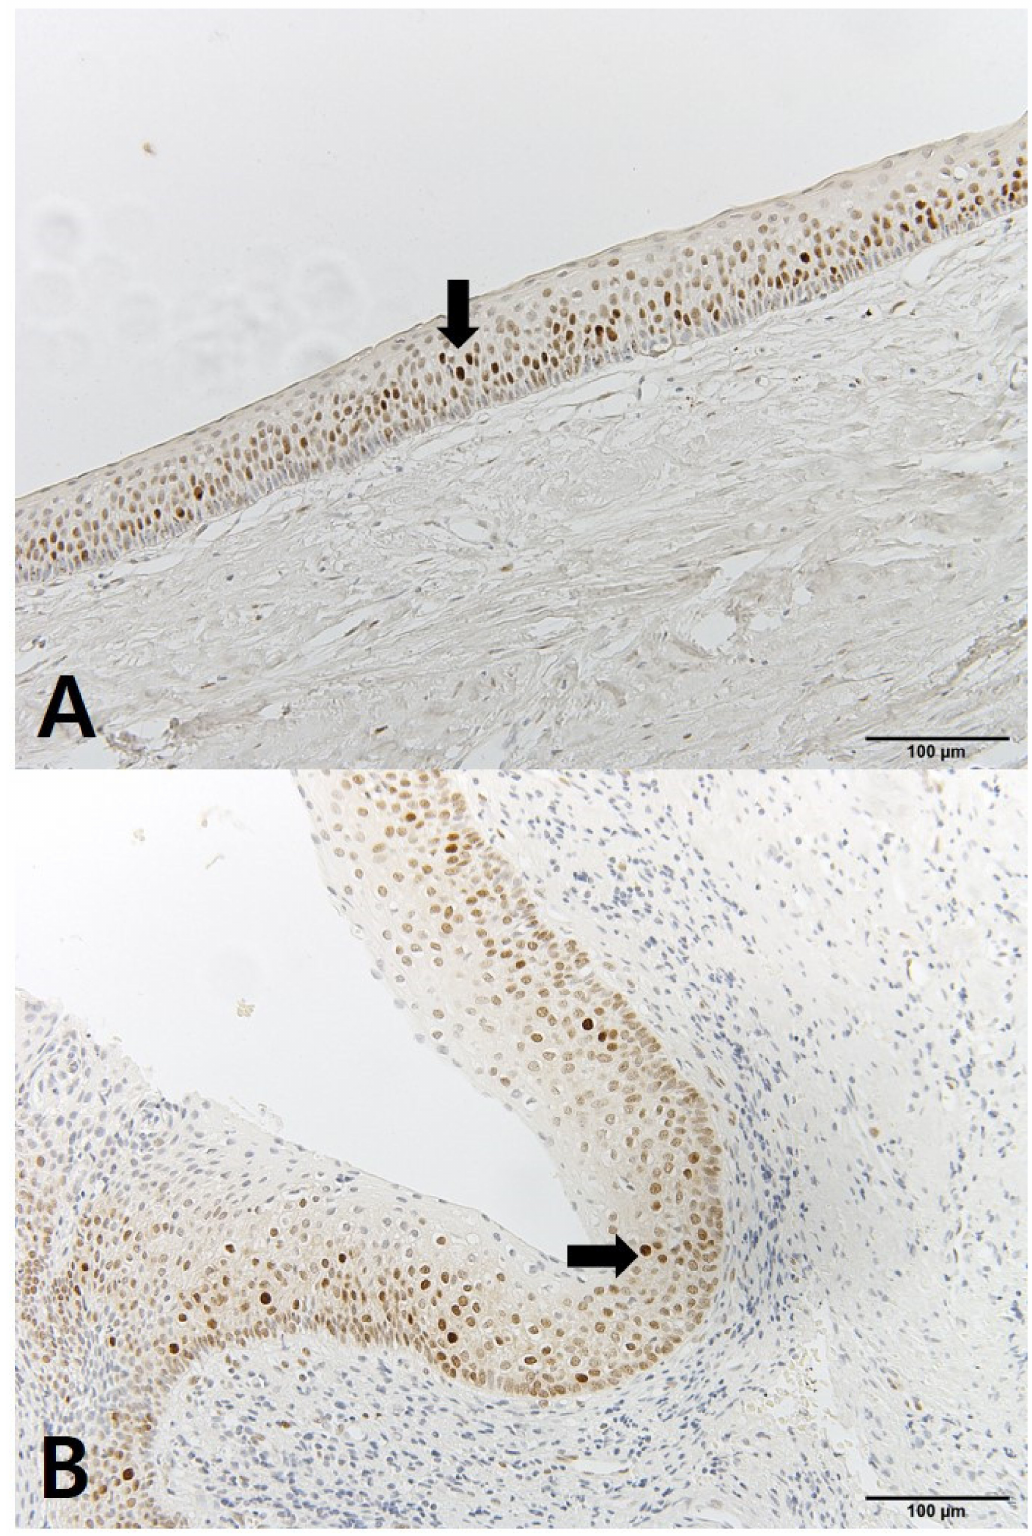
Figure 8. IHC staining of proliferating cell nuclear antigen (PCNA): ( A ) tissue obtained at decompression; ( B ) tissue obtained